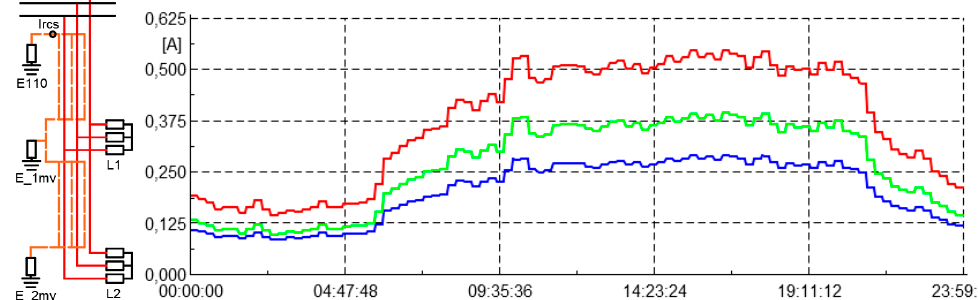
Figure 12. I rcs in case of the break of earthing system continuity: Re1mv—green, Remv2—blue; red—reference curve—no failure. Feeder configuration is marked with colors red—energized cable—and orange—cable screen. Cable cross section: 3x150 / 25, length of segments: 1 km,